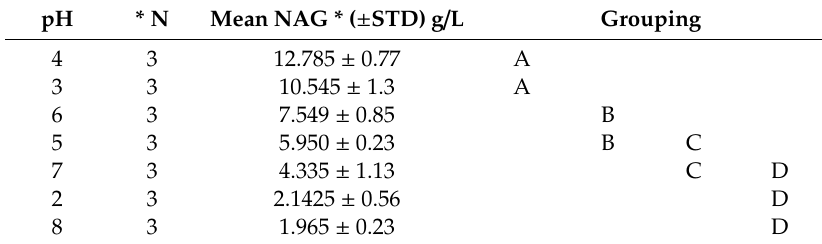
Table 3. The mean N-acetyl-d-glucosamine (NAG) produced by T. harzianum at di ff erent initial pH values.